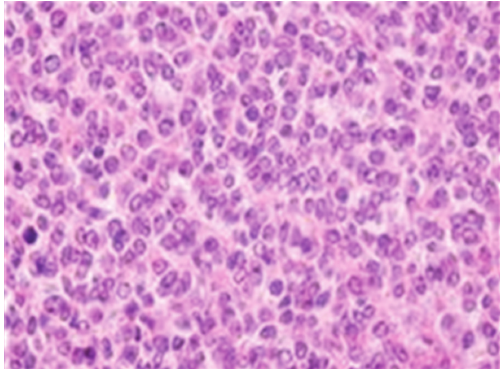
Figure 2: Typical histologicalspecimen which showssheets of small round uniform cells without clear cell boundaries and round to oval nuclei with finely dispersed chromatin and one-to-two small nucleoli (HE).